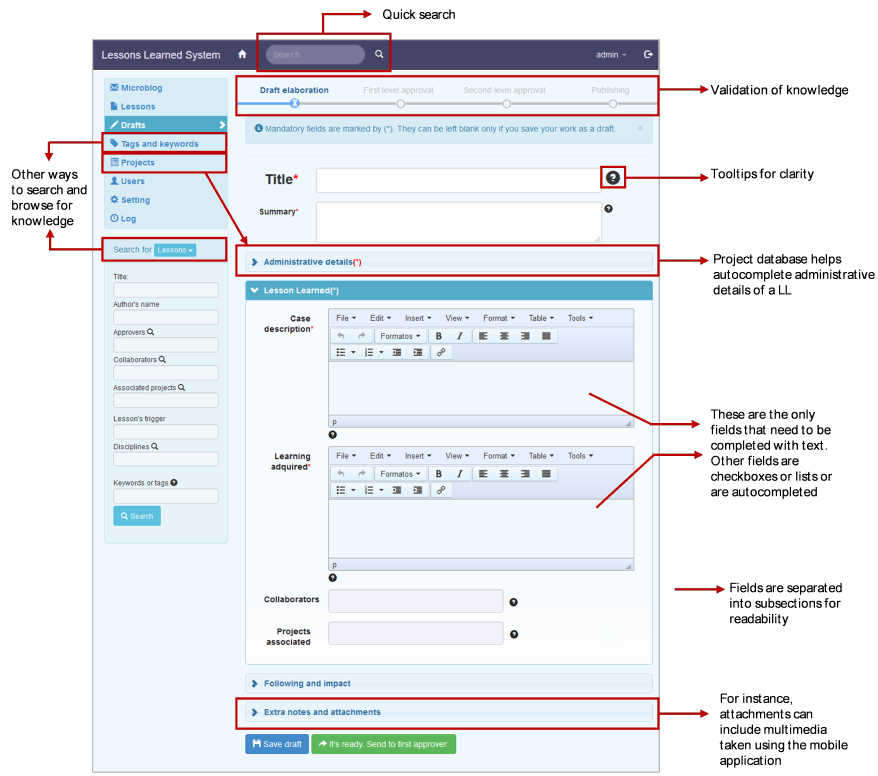
Figure 4. Screenshot from the LL form in the Web